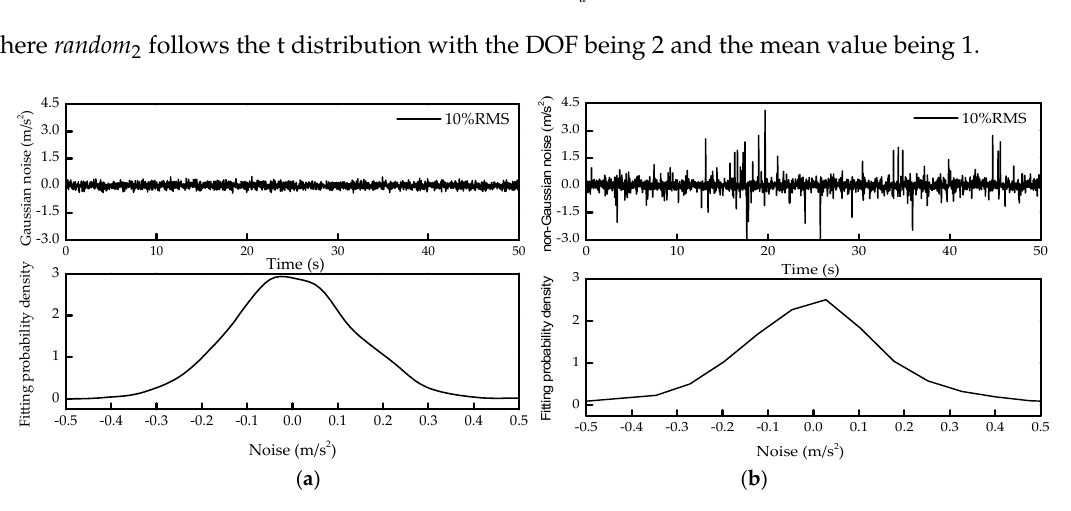
Figure 7. The distribution curves of Gaussian and non ‐ Gaussian noises: ( a ) 10% root mean square RMS for Gaussian noise; ( b ) 10% root mean square for non ‐ Gaussian noise.